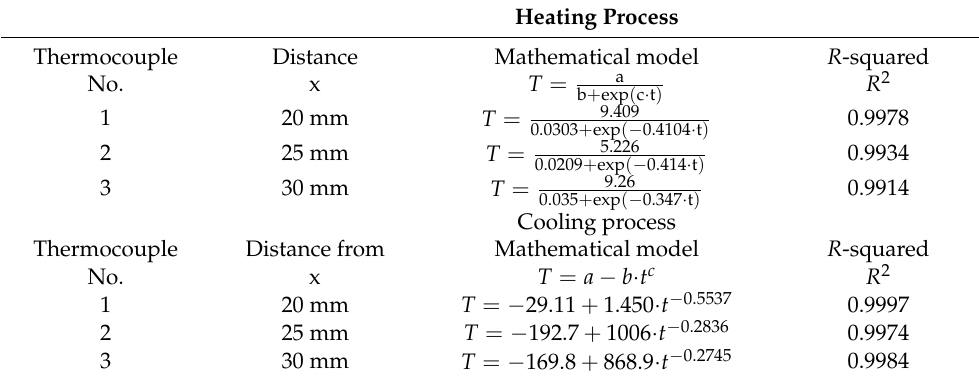
Table 3. Mathematical models for temperature curves during the heating and cooling of the welding process at the half-radius of the specimen.